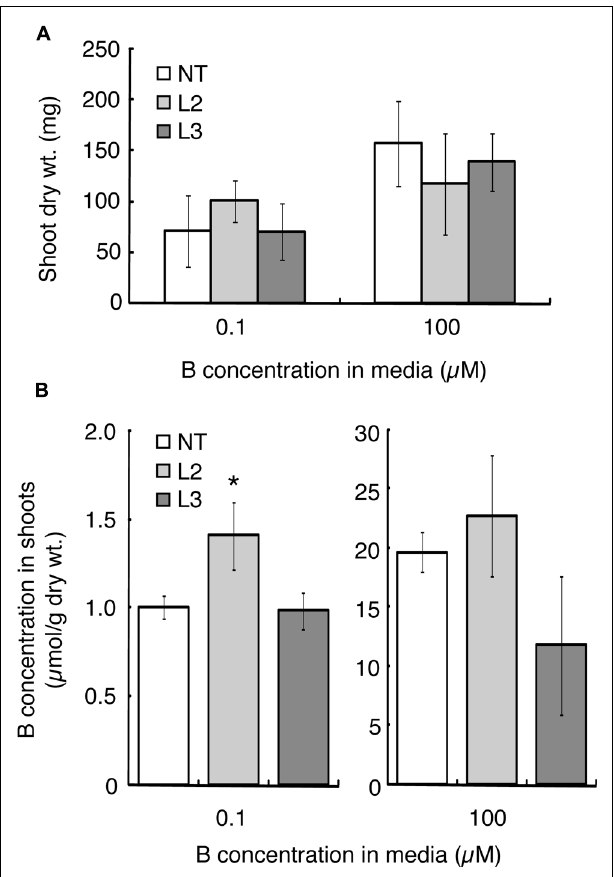
FIGURE 3 | Shoot dry weights and B concentrations in transgenic tomato plants expressing AtBOR1 under B-deficiency and sufficiency. Non-transgenic (NT) and transgenic (L2 and L3) plants were grown for 20 days in a hydroponic solution containing 0.1 or 100 μ M boric acid. Shoot dry weight (A) and B concentration in shoots (B) were measured.Values represent the means ± standard deviation ( n = 3–4). An asterisk indicates significant differences from non-transgenic plants (Student’s t -test, p < 0.05).